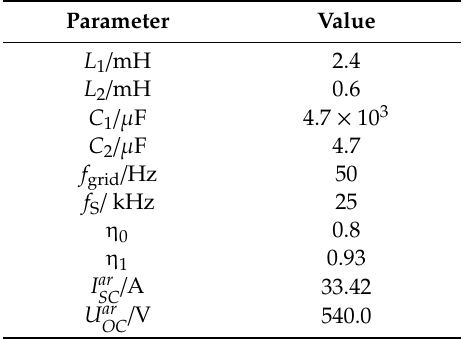
Figure 12. A 1kW prototype experiment. ( a ) Experimental prototype; ( b ) Grid-connected current and grid voltage waveform. Table 2. Parameters of the 1kW experimental prototype.